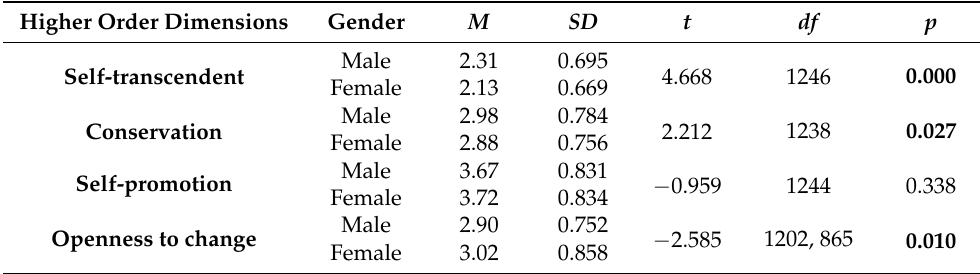
Table 3. Differences in the means of second-order dimensions in relation to gender. Higher Order